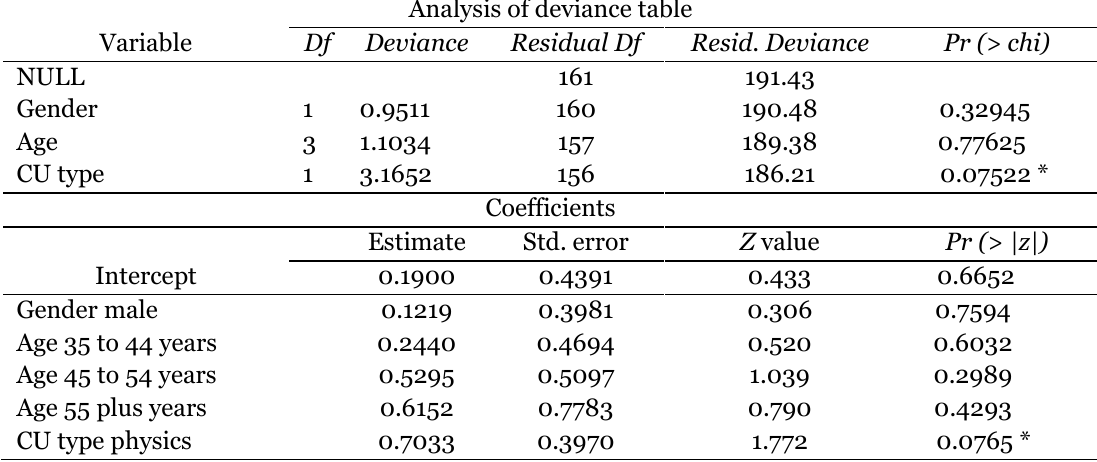
Analysis of deviance